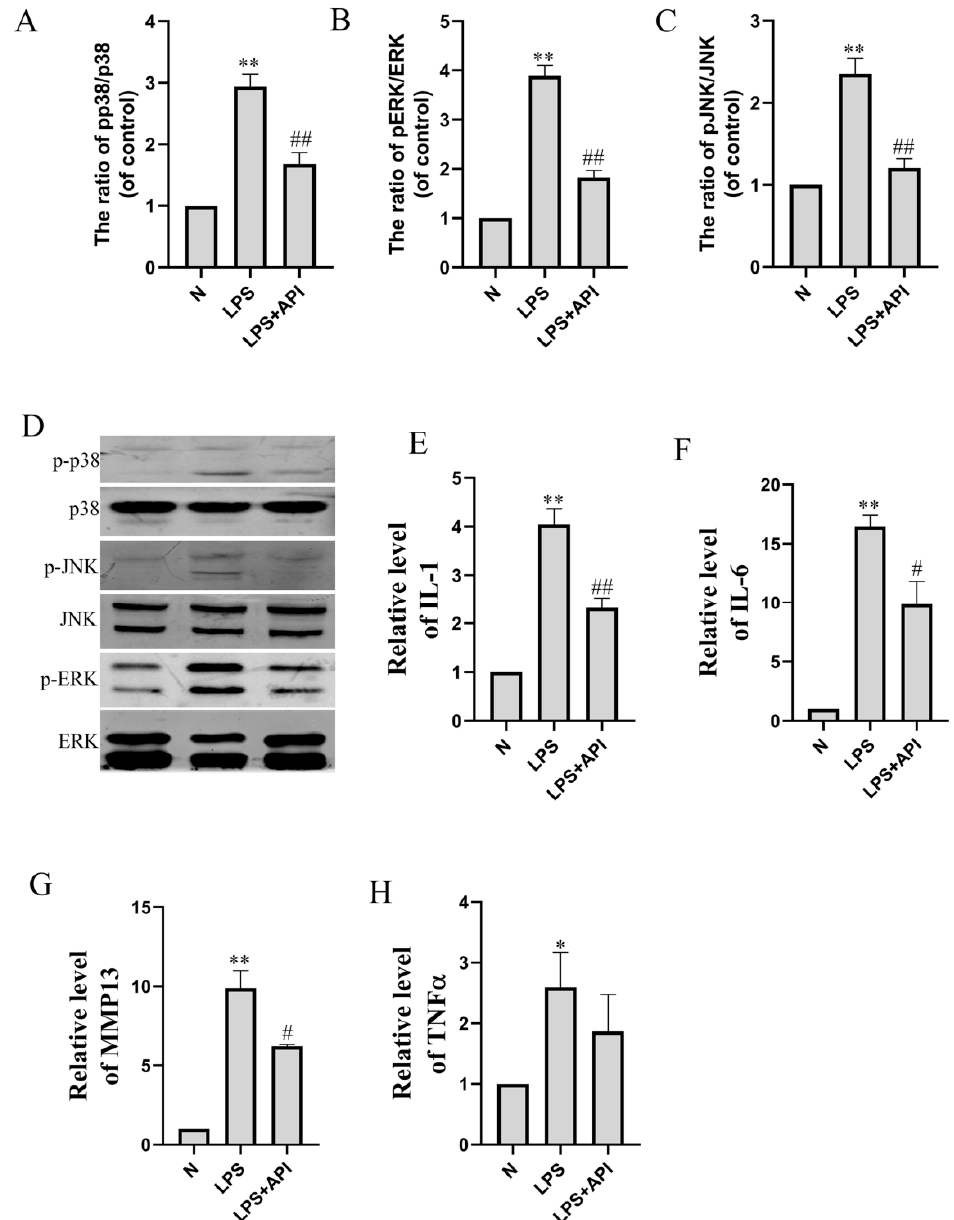
Figure 8. The effect of apigenin on the inflammation-related mRNA and protein levels of chon- drocytes in the macrophage–chondrocyte coculture system. Relative quantities of inflammation- related genes are expressed as fold differences compared to the control. ( A ) p-p38/p38 protein level; ( B ) p-ERK/ERK protein level; ( C ) p-JNK/JNK protein level; ( D ) Representative Western blotting images of p-p38, p38, p-JNK, JNK, p-ERK, and ERK; ( E ) IL-1 mRNA level; ( F ) IL-6 mRNA level; ( G ) MMP13 mRNA level; ( H ) TNF α mRNA level. Data are the mean ± SD of the mean. * p < 0.05 versus normal group (N); ** p < 0.01 versus normal group (N); # p < 0.05 versus LPS group; ## p < 0.01 versus LPS